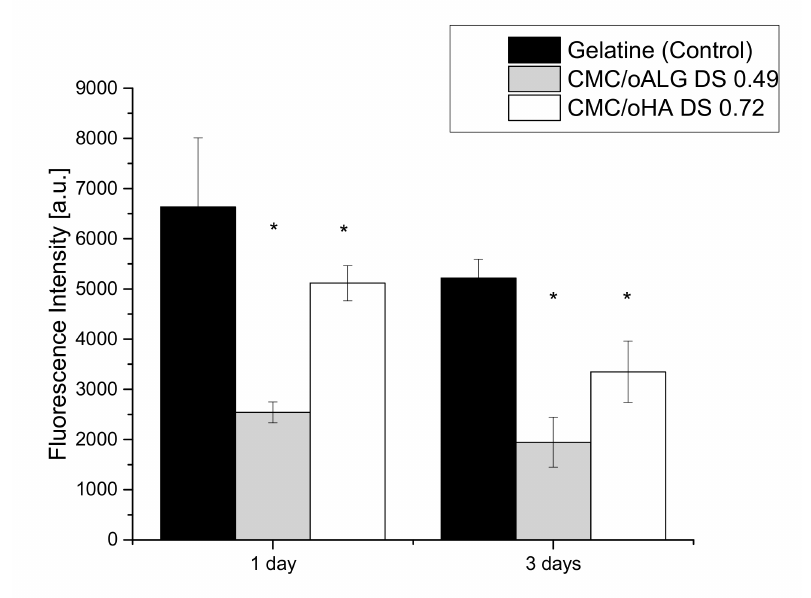
Figure 7. Viability studies by Q-blue assay of C3H10T1 / 2 mouse stem cells incubated in hydrogels, containing carboxymethyl chitosan (CMC) and oxidized hyaluronic acid or oxidized alginate for 24 and 72 h. Data represent mean ± SD values normalized to control, n = 4, * p ≤